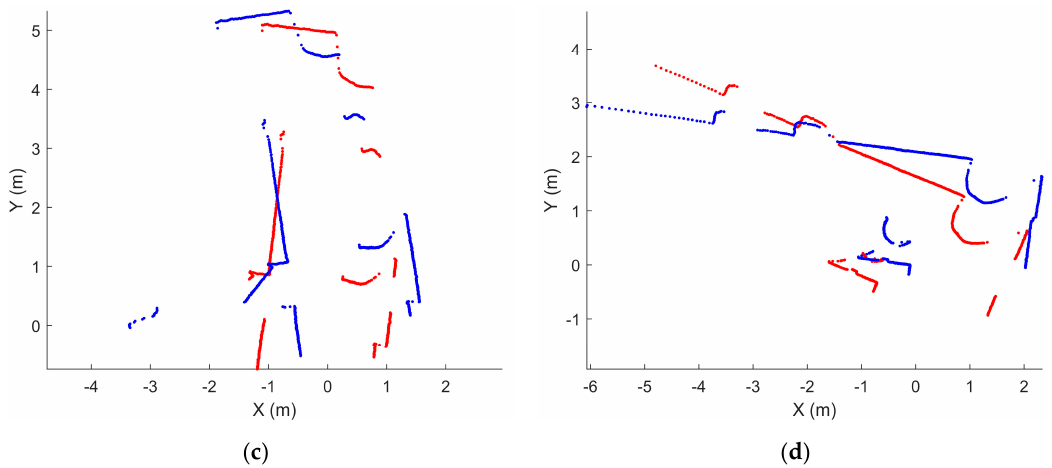
Figure 13. ( a ) Scans obtained in corridor 1 (red dots-reference scan, blue dots-object scan); ( b ) scans obtained near stairs (red dots-reference scan, blue dots-object scan); ( c ) scans obtained in corridor 2 (red dots-reference scan, blue dots-object scan); ( d ) scans obtained in the corner (red dots-reference scan, blue dots-object scan).